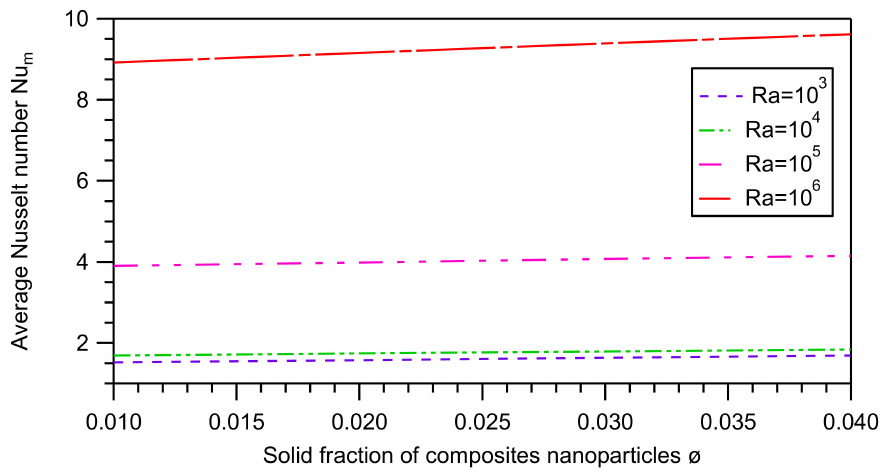
Figure 7. The average Nusselt number Nu m according to the solid fraction of composite nanoparticles ϕ for di ff erent values of Rayleigh numbers (Ra = 10 3 , 10 4 , 10 5 and 10 6 ) with Ha = 15, Da = 10 − 2 , AR = 0.3, ω = 0, Fr = 0.75 and q ∗ = 1.